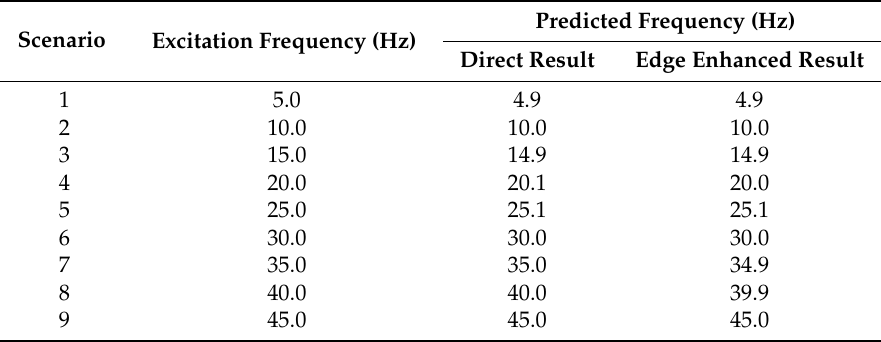
Table 1. Verification test result summary.